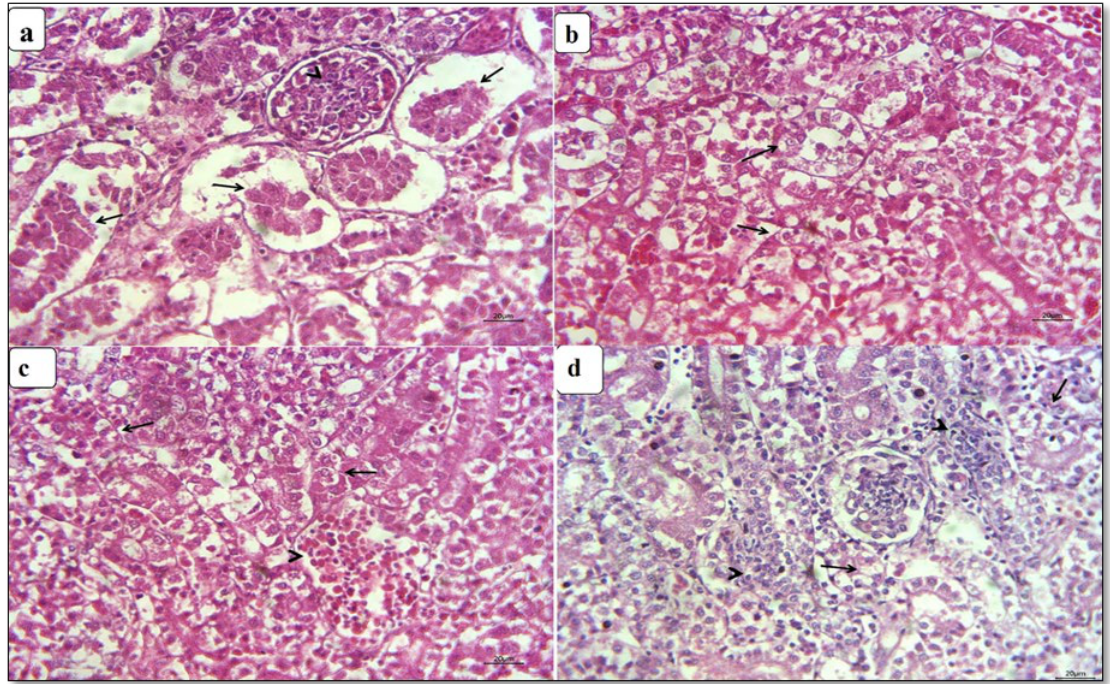
Figure 2. Photomicrographs of kidney sections from CuSO 4 -intoxicated and vitamin-treated groups at the 3rd week: ( a ) the kidney of CuSO 4 -intoxicated chickens shows extensive necrotic tubular epithelia (arrow) and hypercellularity of glomeruli (arrowhead); ( b ) the kidney of CuSO 4 + vitamin C group shows moderate nephritic changes in renal tubular epithelia (arrow); ( c ) the kidney of the CuSO 4 + vitamin E group shows various degenerative changes in some tubular epithelia (arrow) and partial intravascular hemolysis (arrowhead); ( d ) the kidney of CuSO 4 + vitamin C + vitamin E group shows regenerative attempts from tubular epithelia (arrowhead) adjacent to nephritic tubules (arrow).